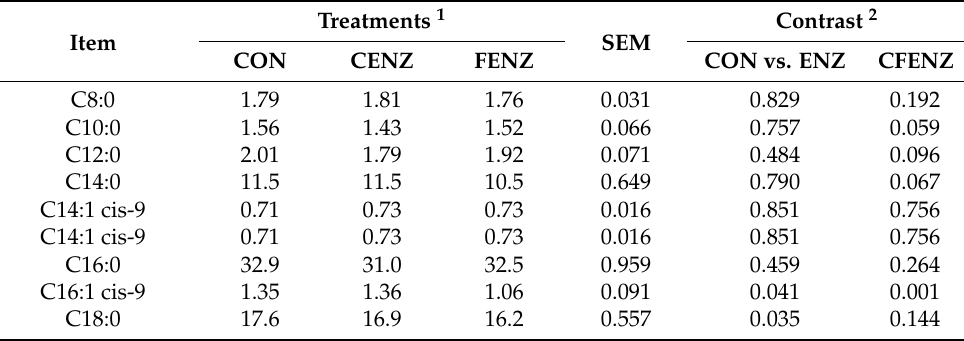
Table 5. Milk fatty acid composition (g/100 g of total FA) of dairy buffaloes as affected by cellulase enzyme supplementation to the